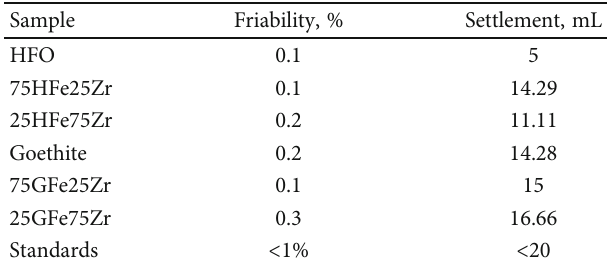
Table 5: Mechanical properties of the catalysts used in the degradation of